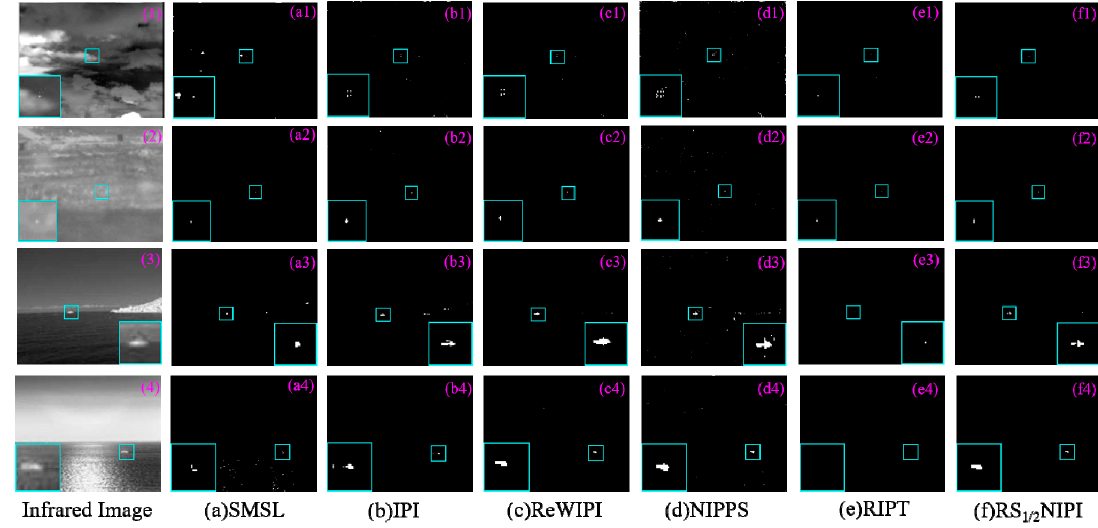
Figure 8. Representative single target images from the datasets and the separated target images obtained by six low-rank recovery-based methods. ( 1 )–( 4 ) are four representative single target images from the tested datasets.